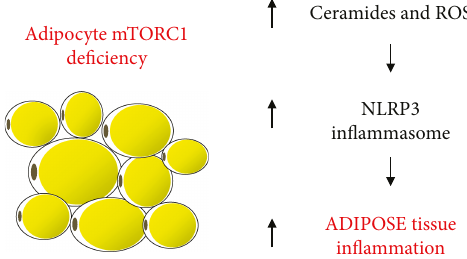
Figure 2: Mechanisms underlying adipose tissue chronic in fl ammation induced by mTORC1 de fi ciency in adipocytes. ROS: reactive oxygen